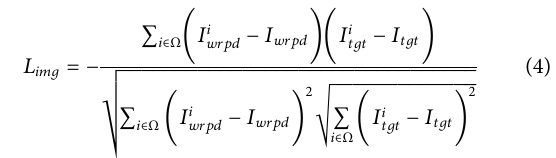
introduced a few modi fi cations as described below. The paper will